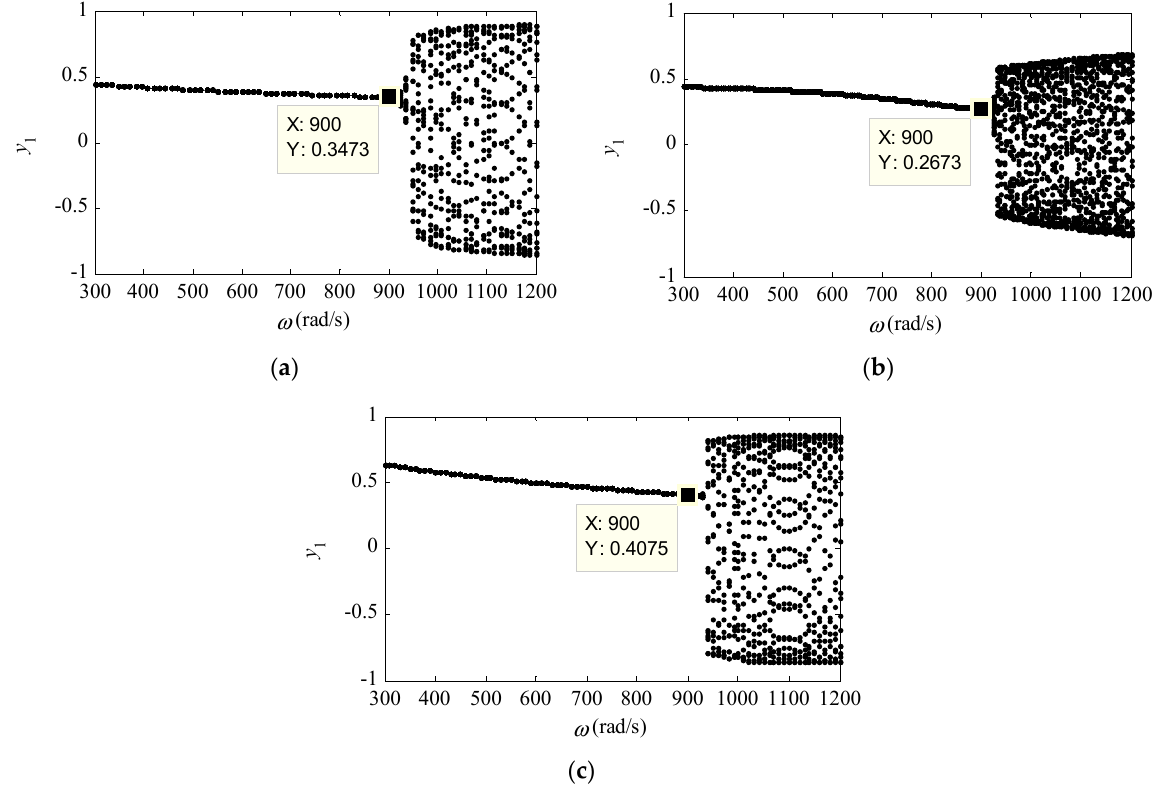
Figure 10. Bifurcation diagram for the optimal sampling length at ω = 350 rad/s ( a ) original system, ( b ) the POM of 2-DOFs, ( c ) the POM of 3-DOFs